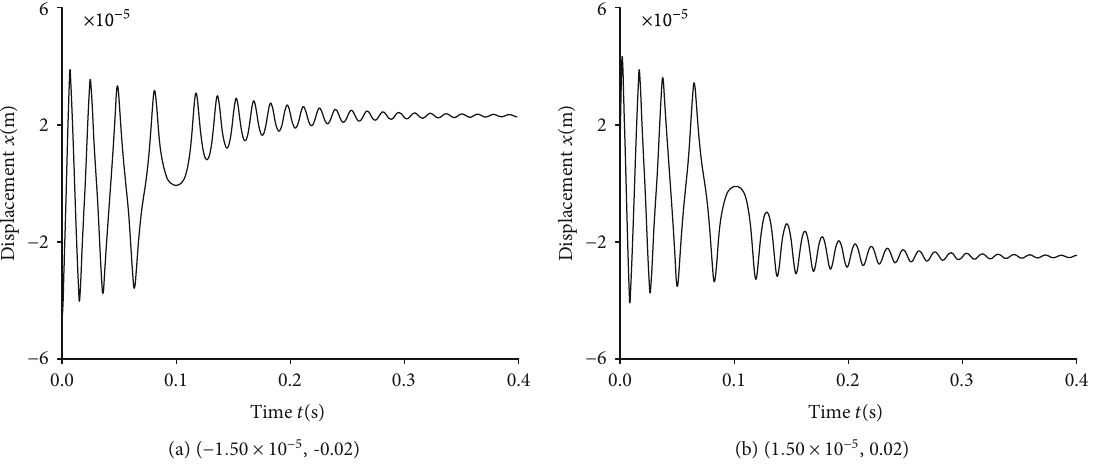
= 6 : 0 × 10 − 5 m , l = 0 : 5 × 10 − 5 m 0